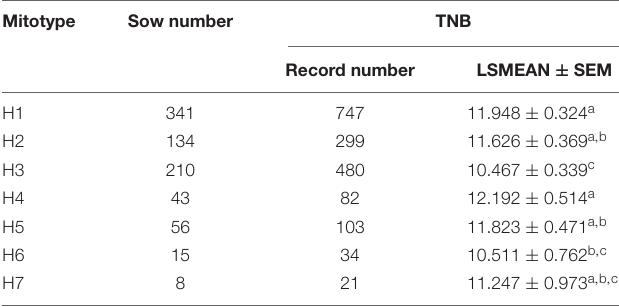
TABLE 1 | Association analysis of TNBs and mitotypes.